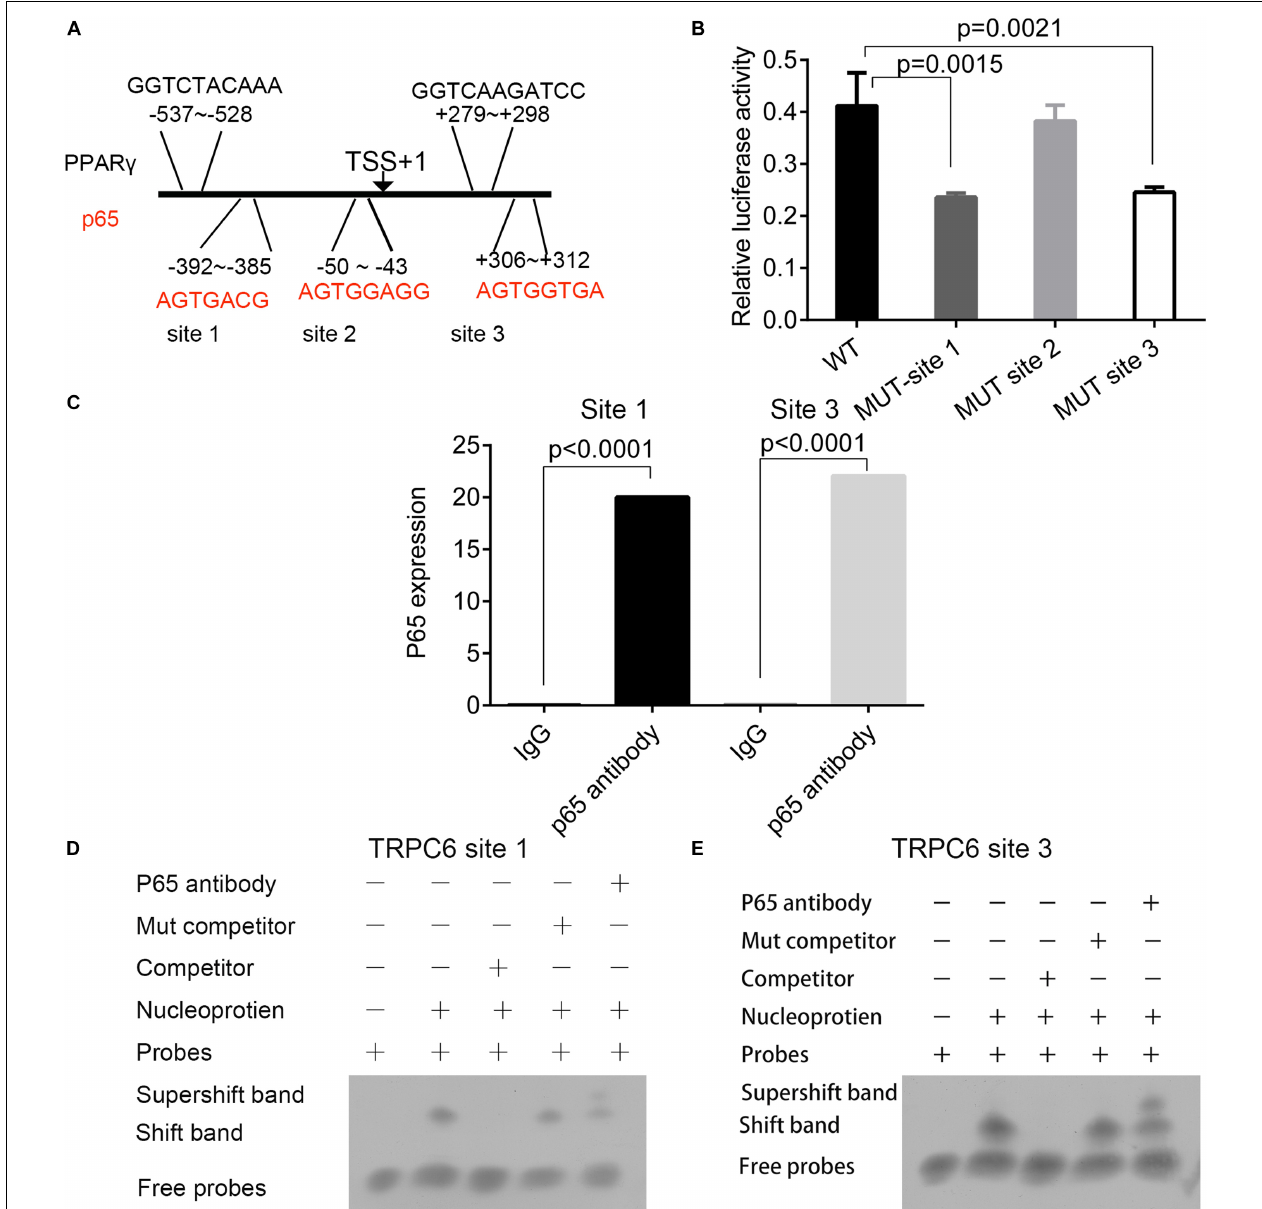
FIGURE 7 | The prediction and validation of p65 protein binding to the promoter region of TRPC6. (A) The predicted binding sites of the p65 and PPAR γ proteins in the promoter regions of the TRPC6 gene. (B) The validation of the binding of the p65 protein on the three sites in the promoter of the TRPC6 gene using the dual-luciferase reporter assay. (C) ChIP confirmed the binding of p65 antibodies to the site 1 and site 3 regions on the promoter region of the TRPC6 gene. (D,E) EMSA for the binding of the p65 antibody on the two sites. The differences were analyzed using one-way ANOVA. CTRL, control.